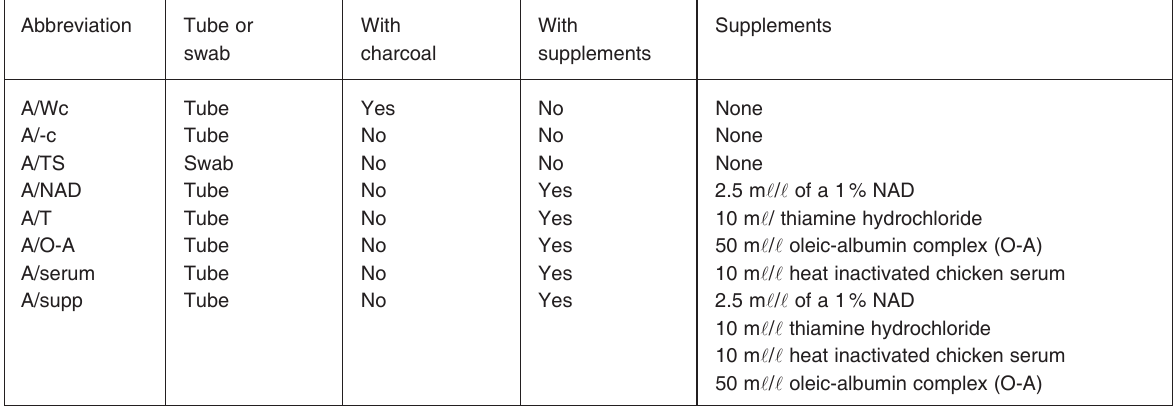
TABLE 1 Abbreviations of the different transport media evaluated for the transport of H. paragallinarum